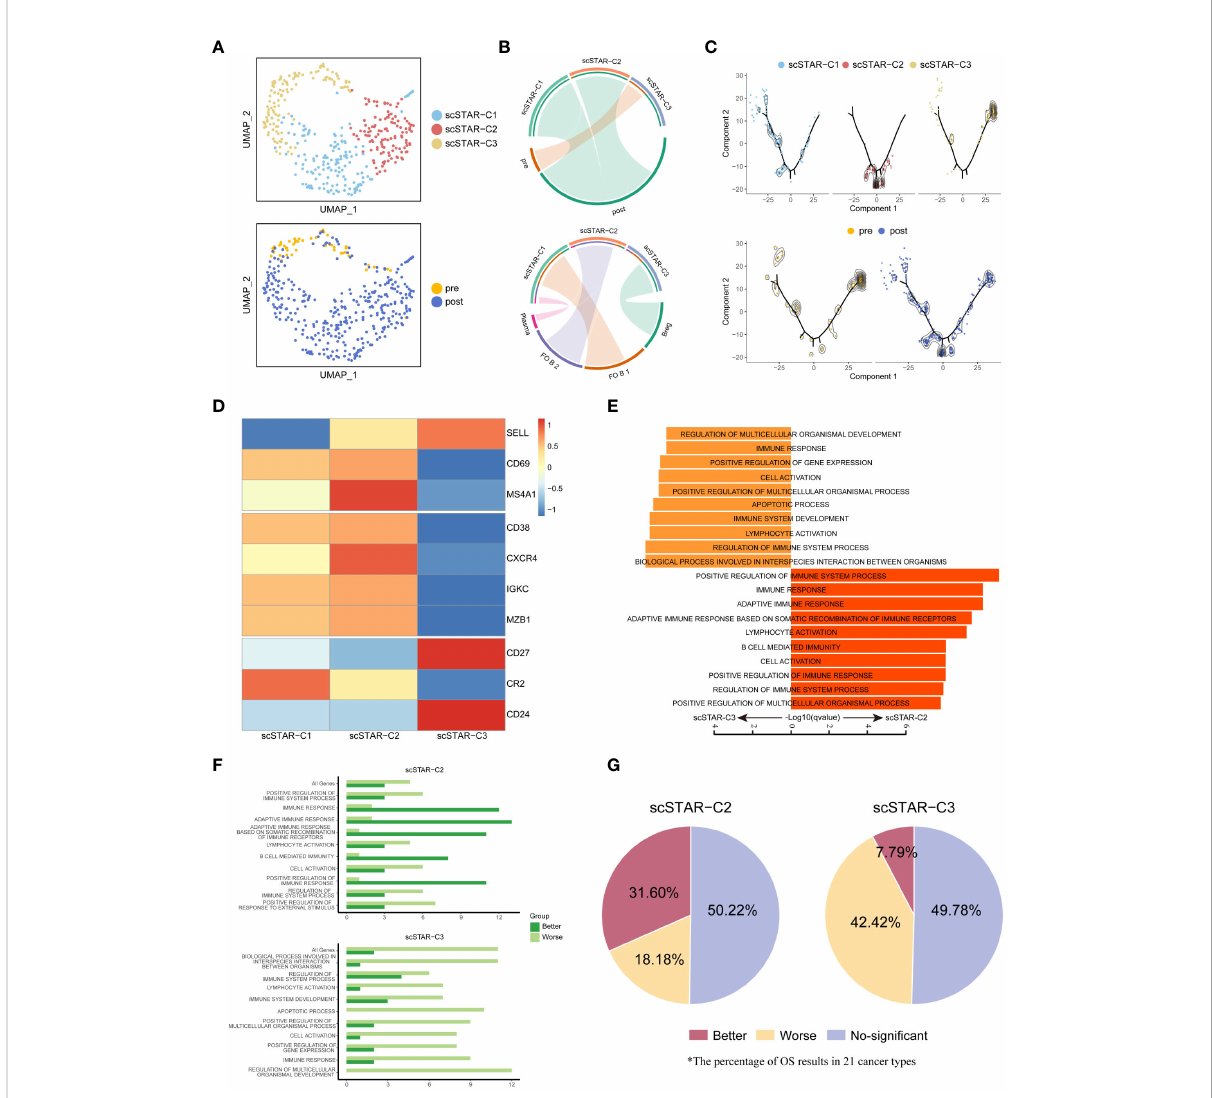
FIGURE 7 The association between molecular functional dynamics of B cells subsets and prognosis. (A) UMAP of B cells processed by the scSTAR algorithm, colored by sample and cluster. (B) The association between scSTAR-processed clusters and treatment (above) or B cell subclusters (down). The area of the ties represents the relative enrichment. (C) Trajectory analysis for the three scSTAR-processed clusters. Each point corresponds to an individual cell colored by cluster (above) or by sample (down). The density curves represent the distribution of each cluster. (D) Heatmap of scaled normalized expression for B cell function genes. (E) Pathway enrichment analysis of genes in scSTAR-C2 and scSTAR-C3, respectively. The bar plot showed the top 10 enriched GO pathways. Benjamini-Hochberg (BH) adjusted p value < 0.05. (F) The number of associations between all changed genes, pathways in which scSTAR-C2 or scSTAR-C3 was involved and better or worse overall survival in the 21 tumor types. (G) The percentage of prognosis results predicted by scSTAR-C2 and scSTAR-C3 in 21 cancer